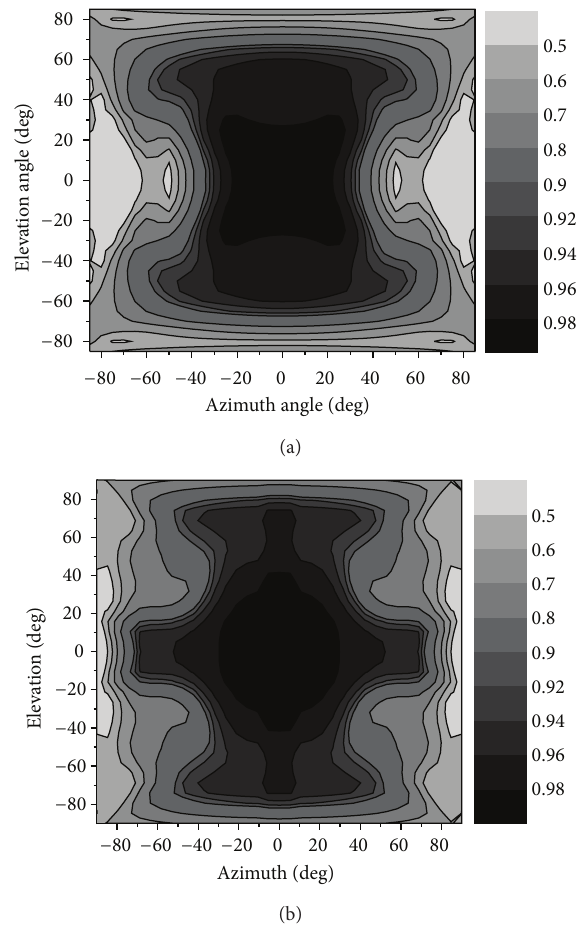
Figure 10: (a) Fidelity factor test results of the original antenna and (b) fidelity factor test results of the improved